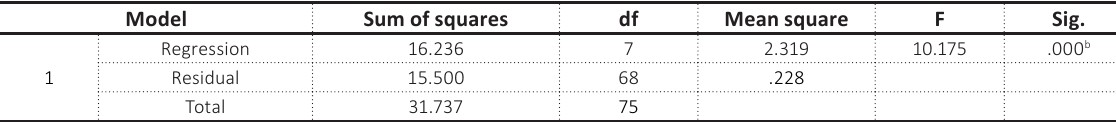
Table 6. Regression goodness-of-fit – SLC-OC